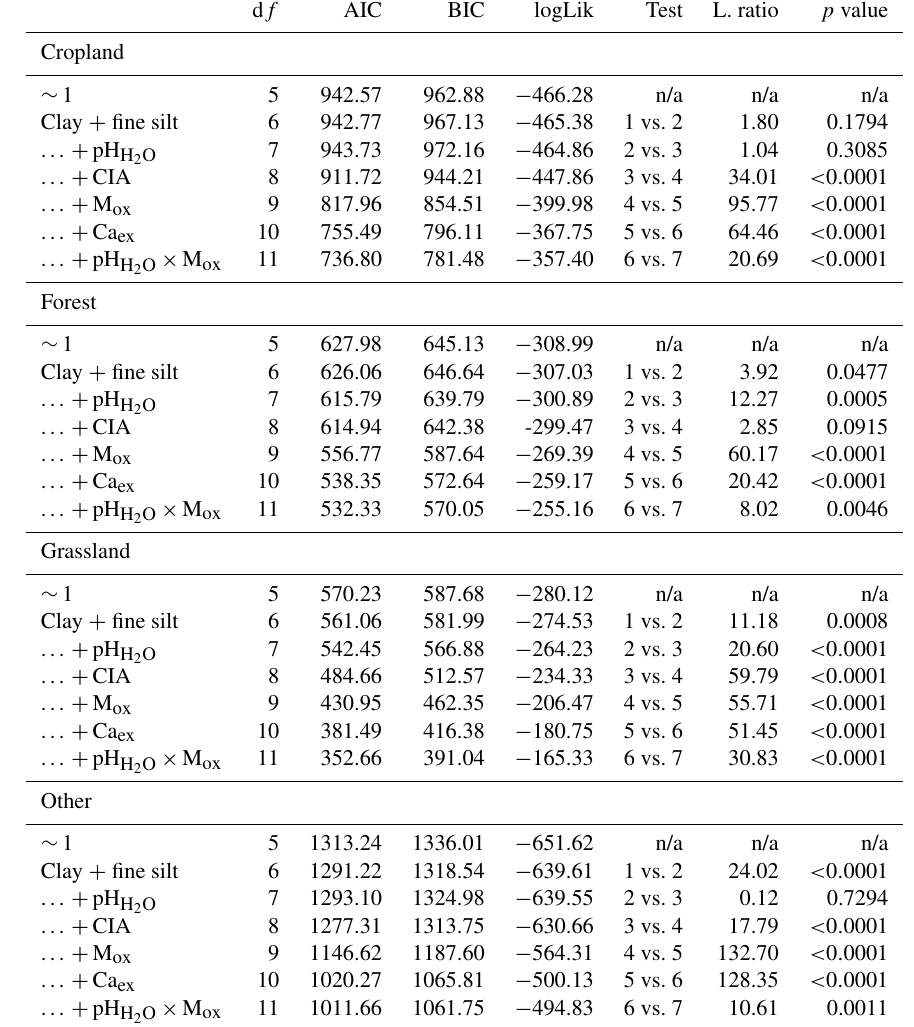
Table B9. ANOVA summary for linear mixed-effects grouped by land cover ( n Cropland = 429; n Forest = 228; n Grassland = 242; n Other = 702). Fixed effects were added using a step-wise method. The first entry ( ∼ 1) refers to the constant null model,